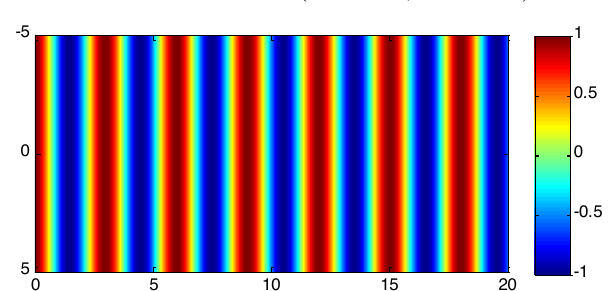
Fig. 1. Schematic drawing of the domain (0–20 ◦ E, 5 ◦ S–5 ◦ N) for Figure 1. Schematic drawing of the domain ( 0 ◦ - 20 ◦ E, 5 ◦ S - 5 ◦ N) for the regional simulation. the regional simulation. A cosine wave oscillation with amplitude of 30ms − 1 has been applied to the zonal wind at the lower bound- A cosine wave oscillation with amplitude of 30 m/s ha been applied to the zonal wind at the x − ωt) , where λ is the ary at 100km altitude ( V east = 30 · cos ( 2 π λ wavelength, x is the longitude, ω is the frequency and t is the = 30 · cos ( 2 π x − ωt ) , where λ is the wavelength, x is lower boundary at 100 km altitude ( V east λ ω is the frequency and t is the time). the longitude,